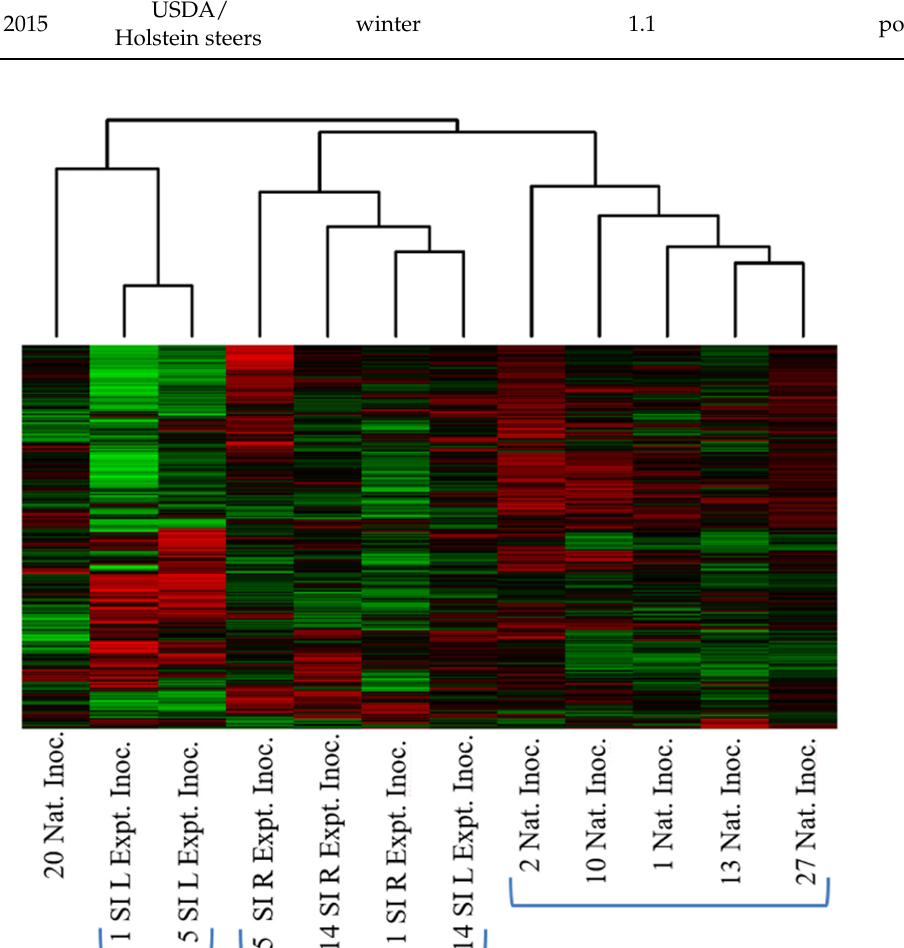
Figure 6. Heatmap and clustering analysis of peripheral lymph nodes from cattle that were experi- mentally or naturally infected with Salmonella and clustered based on the relative similarity of the kinome profiles. Two obvious clusters of natural and experimental infection are observed to the right and center of the figure. Each column represents a tissue sample; each row is a peptide. Red represents relative increase in phosphorylation and green relative decrease.